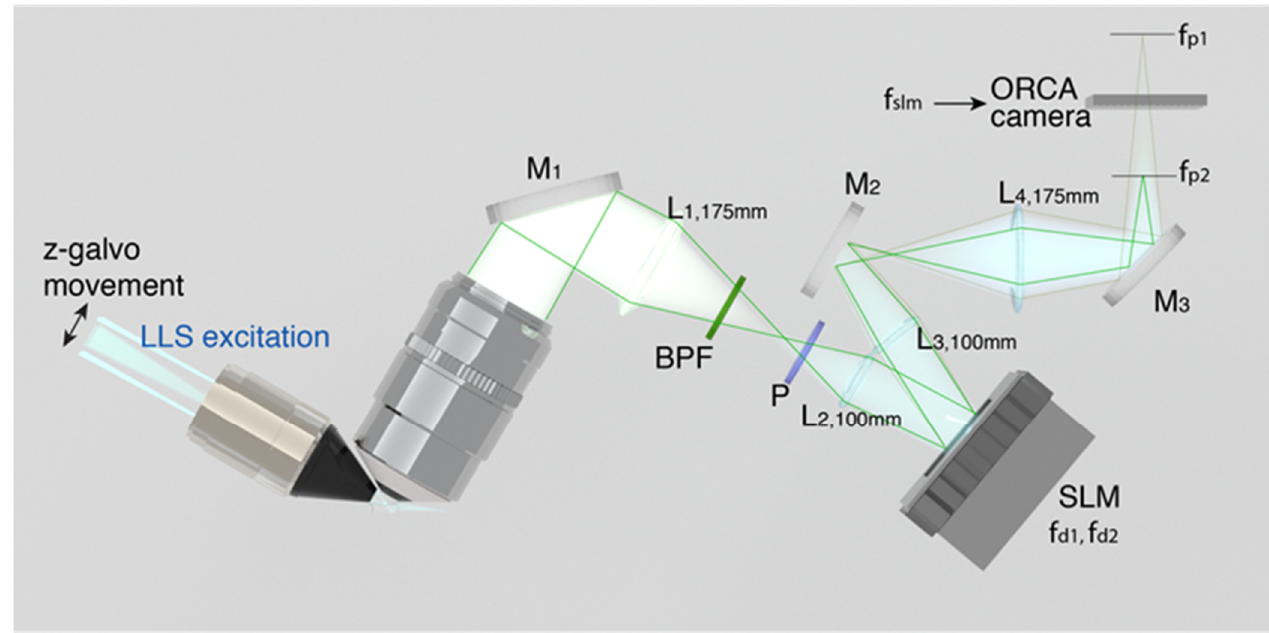
Figure 24. Schematics of the IHLLS systems with one diffractive lens of focal length, f SLM = 400 mm (IHLLS 1L) and two diffractive lenses with focal lengths f d1 = 220 mm and f d2 = 2356 mm (IHLLS 2L). A collimated 30 Bessel beam is focused by an excitation objective lens which generates a lattice light sheet. It excites fluorophores in the focal plane and in/off the focal plane of the detection objective lens, which is a water immersed microscope objective MO (Nikon 25X, NA 1.1, WD 2 mm). The detection system also includes two pairs of lenses for beam size adjustment to fit the size of the SLM active area, L 1 = L 4 with focal lengths 175 mm, L 2 = L 3 with focal lengths 100 mm; mirrors M 1 , M 2 , M 3 ; polarizer P; 40 nm band pass filter BPF centered on the 520 nm wavelength, spatial light modulator SLM, and CMOS camera. While the z-galvo and z-piezo are moved along the z axis to acquire stacks in LLS and IHLLS 1L , in IHLLS 2L only the z-galvo is moved at various z positions (Visualization 1 [41]). The diffraction mask in the excitation path was positioned for all experiments on the anulus of 0.55 outer NA and 0.48 inner NA. The detection magnification M T − LLS = 62.5 and the illumination wavelength λ illumination = 488 nm. The width of the light sheet in the center of the FOV is about 400